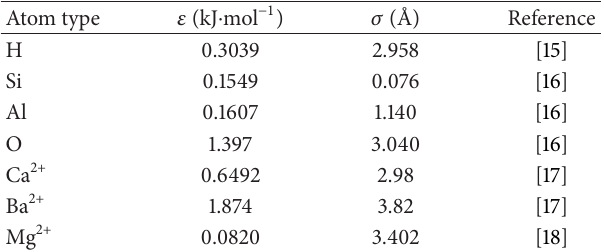
Figure 1: Structure of the X zeolite framework and description of the main crystallographic sites for the extraframework cations. Table 2: Lennard-Jones interaction